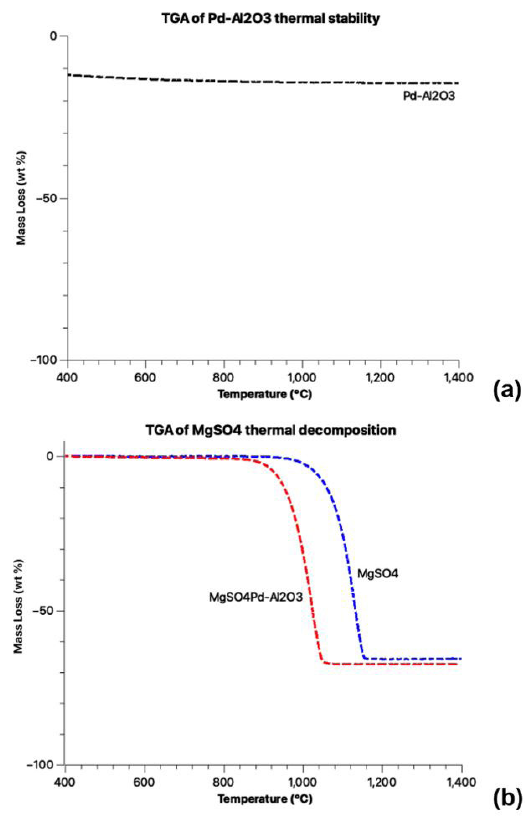
O thermal 2 3 O over the thermal 2 3